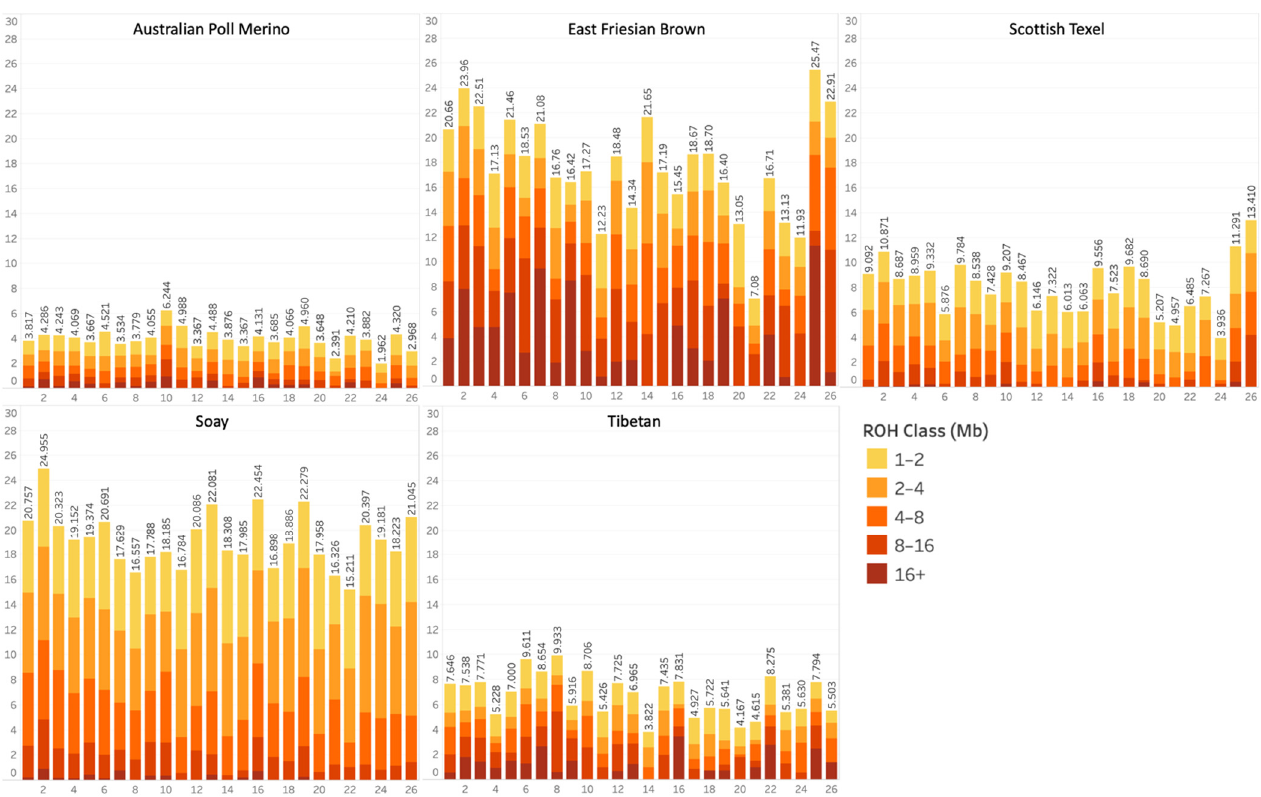
Figure 2. Population average of the proportion of ROH coverage in each autosomal chromosome in five selected sheep populations. The color scale represents the length of the runs of homozygosity (ROH) in Mb, divided into five classes (1–2, 2–4, 4–8, 8–16, and >16 Mb). The results for all the other populations are presented in the Supplementary Material (Tableau file).